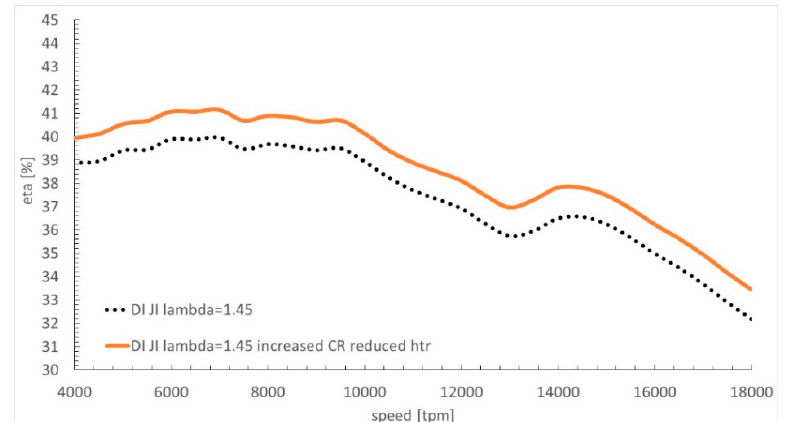
Figure 7. BMEP of lean stratified engines.